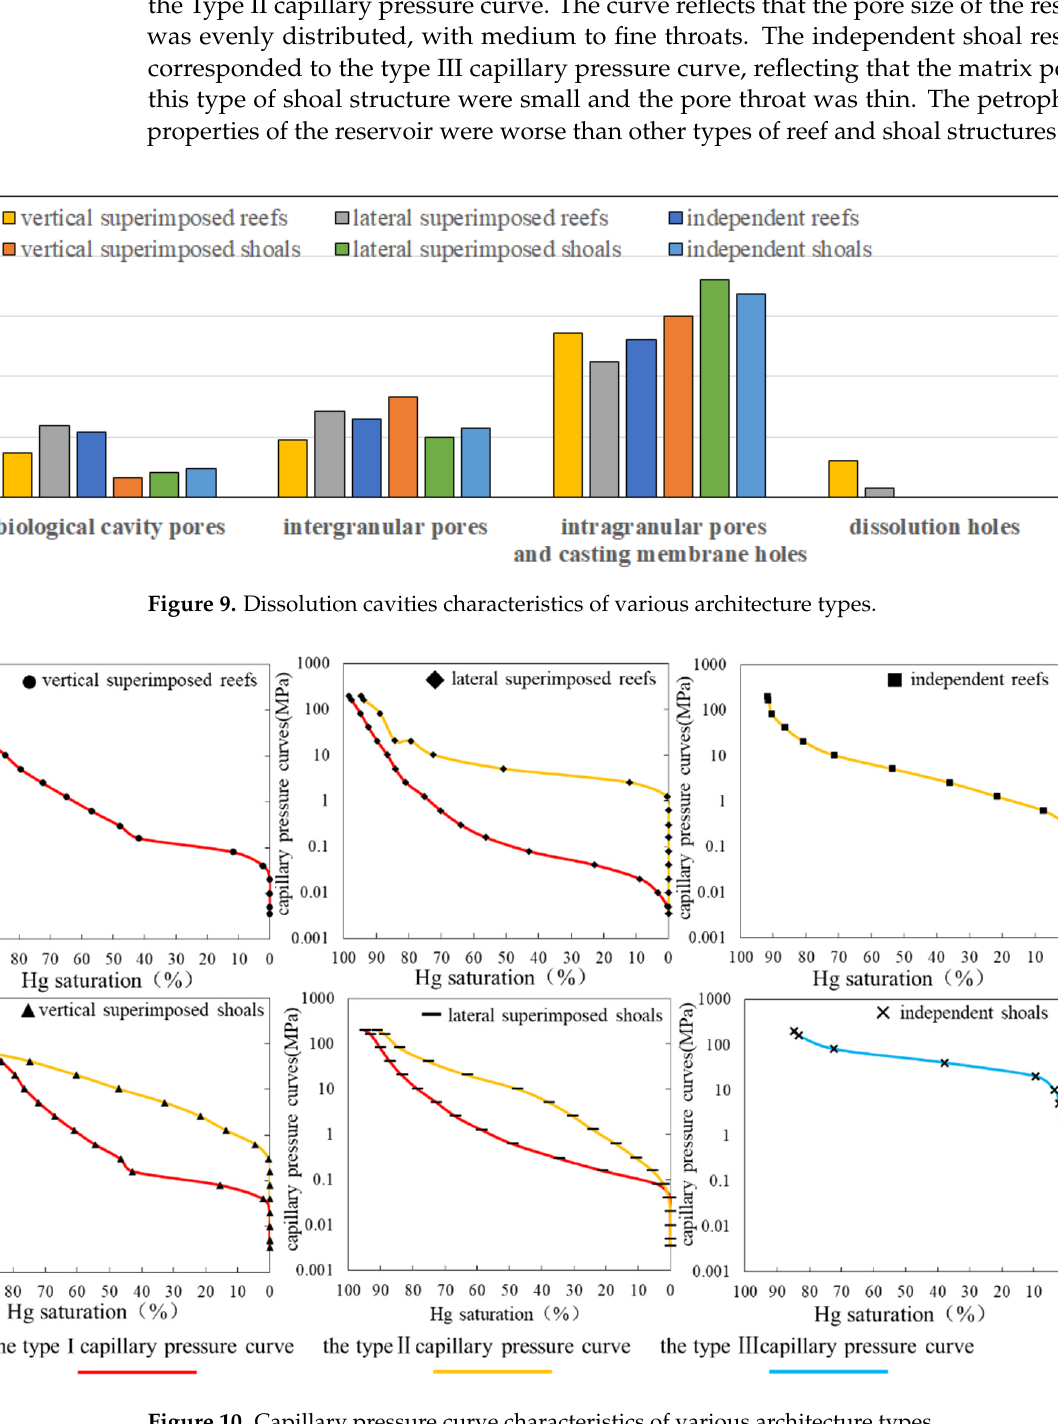
Figure 10. Capillary pressure curve characteristics of various architecture types.